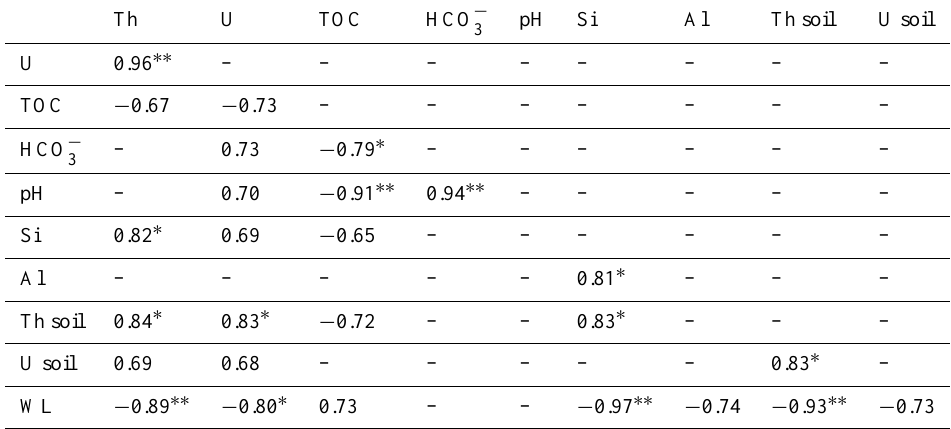
Table 3. Correlation coefficients between selected parameters from Tables 1 and 2. WL stands for the wetland and lake coverage. Unless otherwise stated the correlations are significant at the 95% significance level ( p< 0 . 05 )